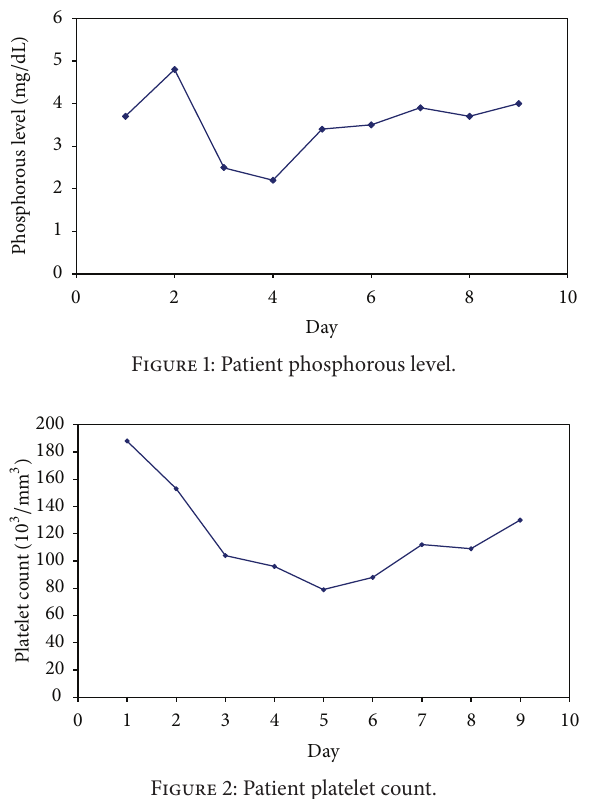
Figure 2: Patient platelet